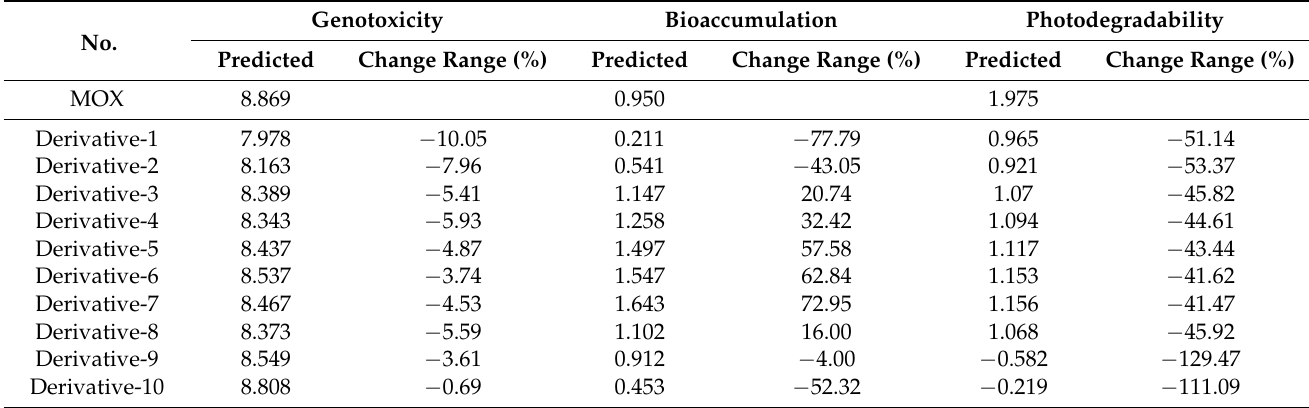
Table 5. Environmental friendliness and functional evaluation of MOX